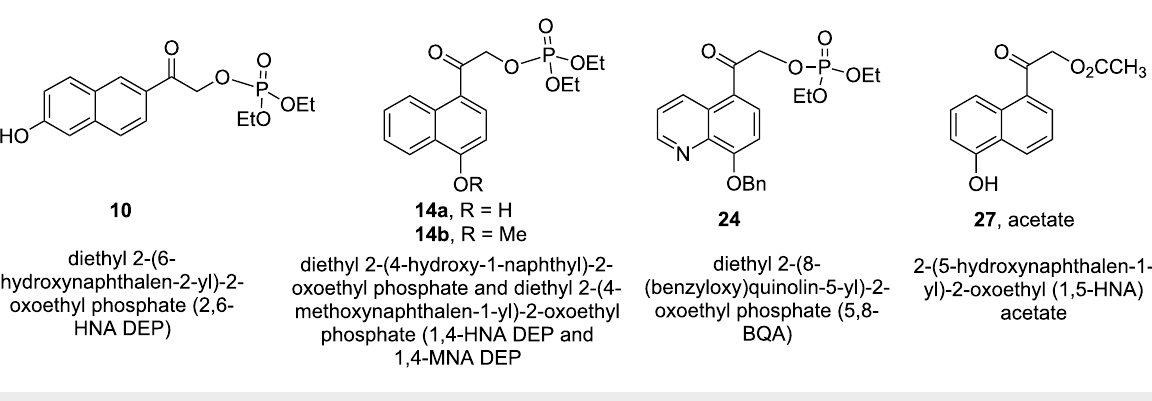
Figure 3: Naphthyl and quinolin-5-yl caged phosphate esters 10 , 14 , 24 and 27 (acetate ester).